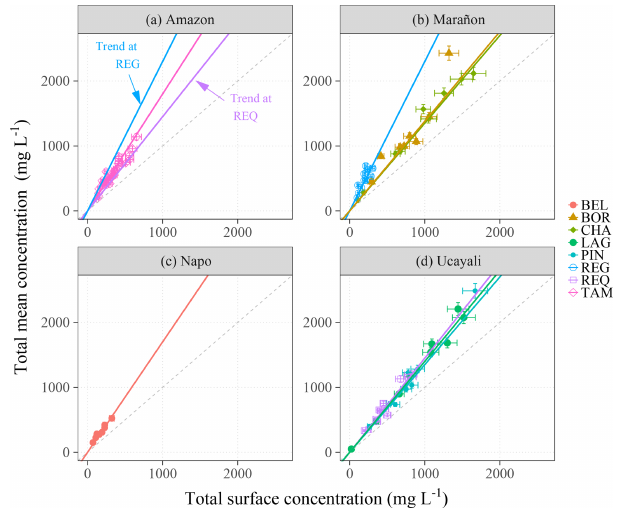
Figure 2. Observed ratios α = (cid:104) C (cid:105) /C ( h ) of the total mean con- centration to the total surface concentration, stacked by river basin, with trend lines. For the Amazon River basin at TAM (a) , the REG and REQ trend lines were reported. Dashed lines denote the first